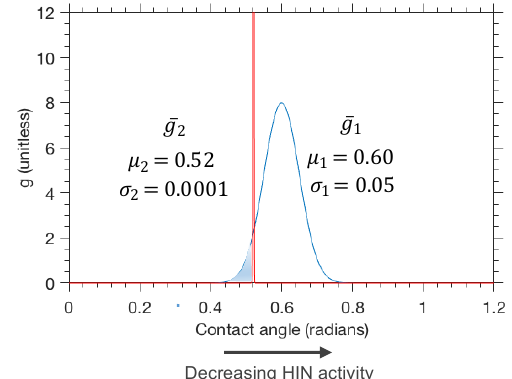
Figure 3. The two distributions of HIN activity, g 1 (right, broad, in blue) and g 2 (left, narrow, in red), retrieved from the Snomax droplet freezing spectra (Fig. 2).